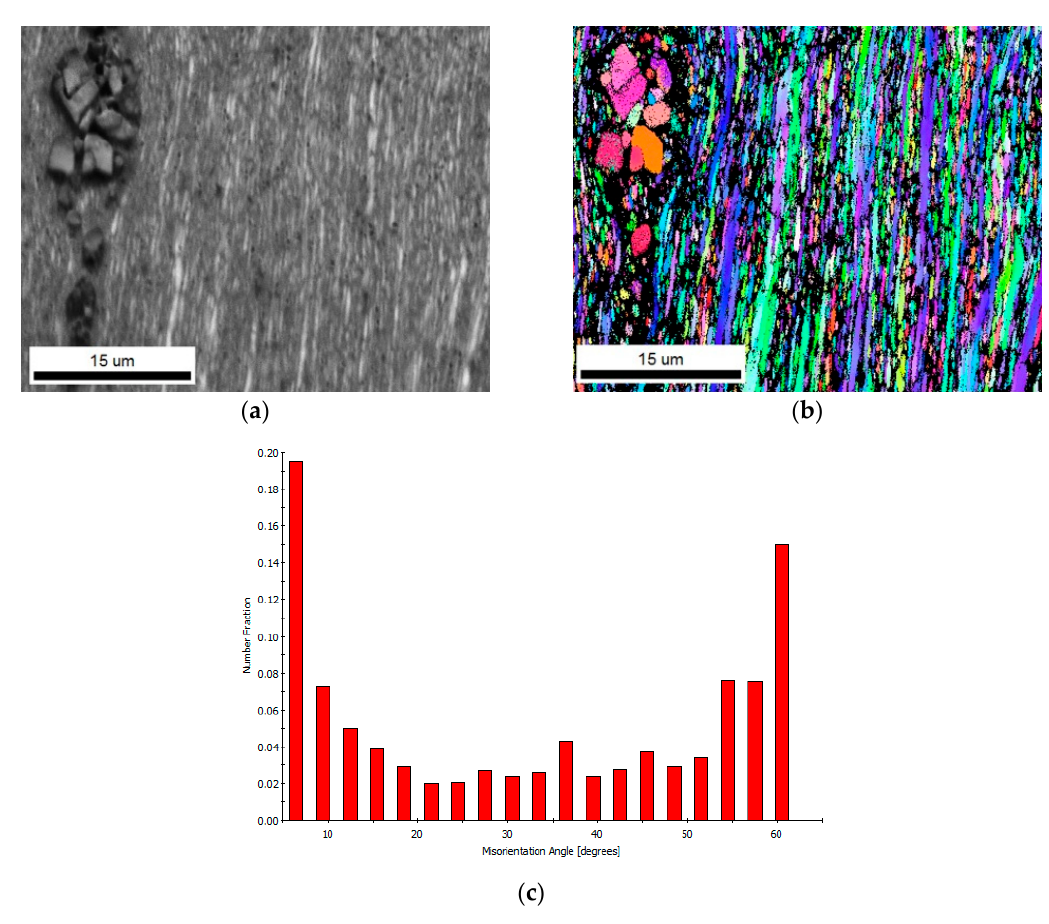
Figure 8. EBSD analysis of the as-received AA5083 after four (D) sc-ECAE passes + 50% rolling reduction: ( a ) image quality map (step size is 25 nm); ( b ) color-coded orientation map; and ( c ) misorientation angle histogram (5° is set as the minimum). Lamellae in ( a , b ) are oriented in the rolling direction.